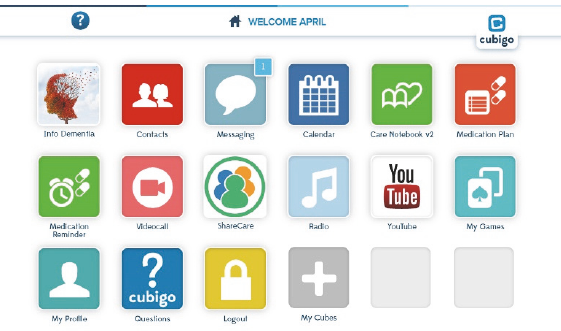
Figure 1: Platform Cubes for family